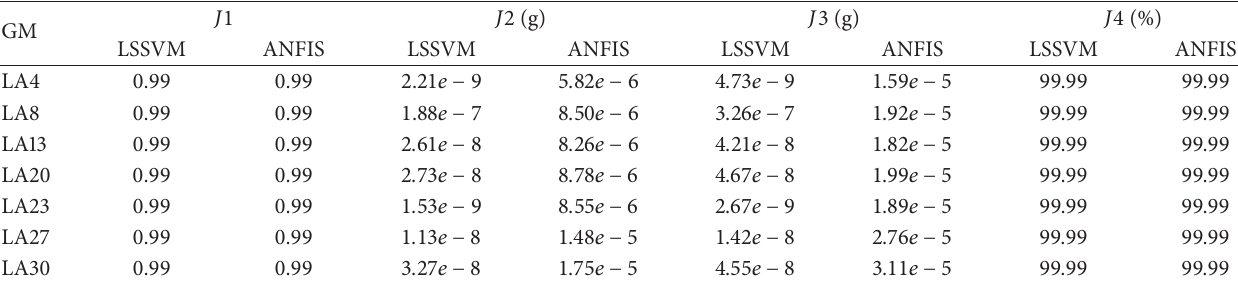
Figure 8: (a) RMSE for RBF kernel trails and (b) values of 𝛼 for building behavior prediction. Table 3: Validation analysis of the LSSVM and ANFIS